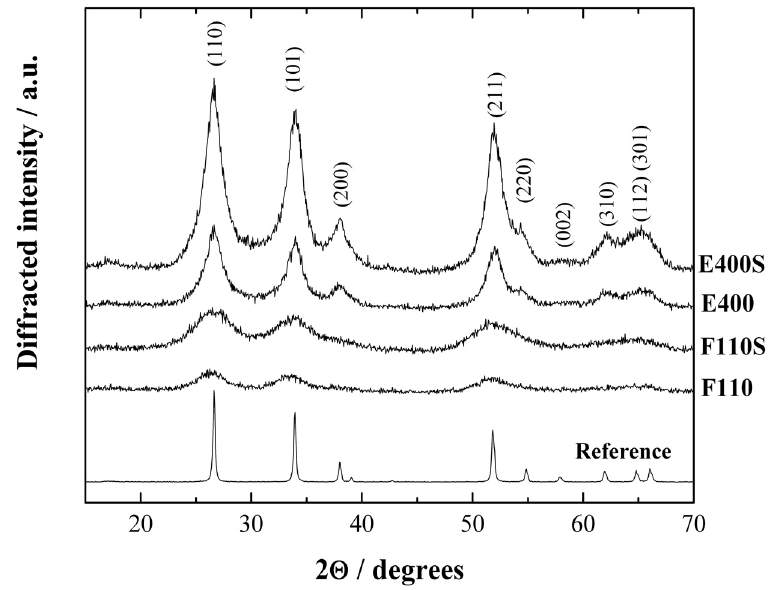
Figure 1. X-ray diffraction (XRD) patterns of the tin oxide samples, bare and sulphated. bulk Reference: SnO 2